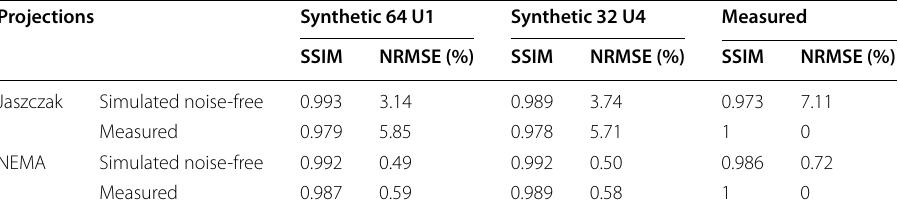
Table 5 Analysis of physical phantom measurements